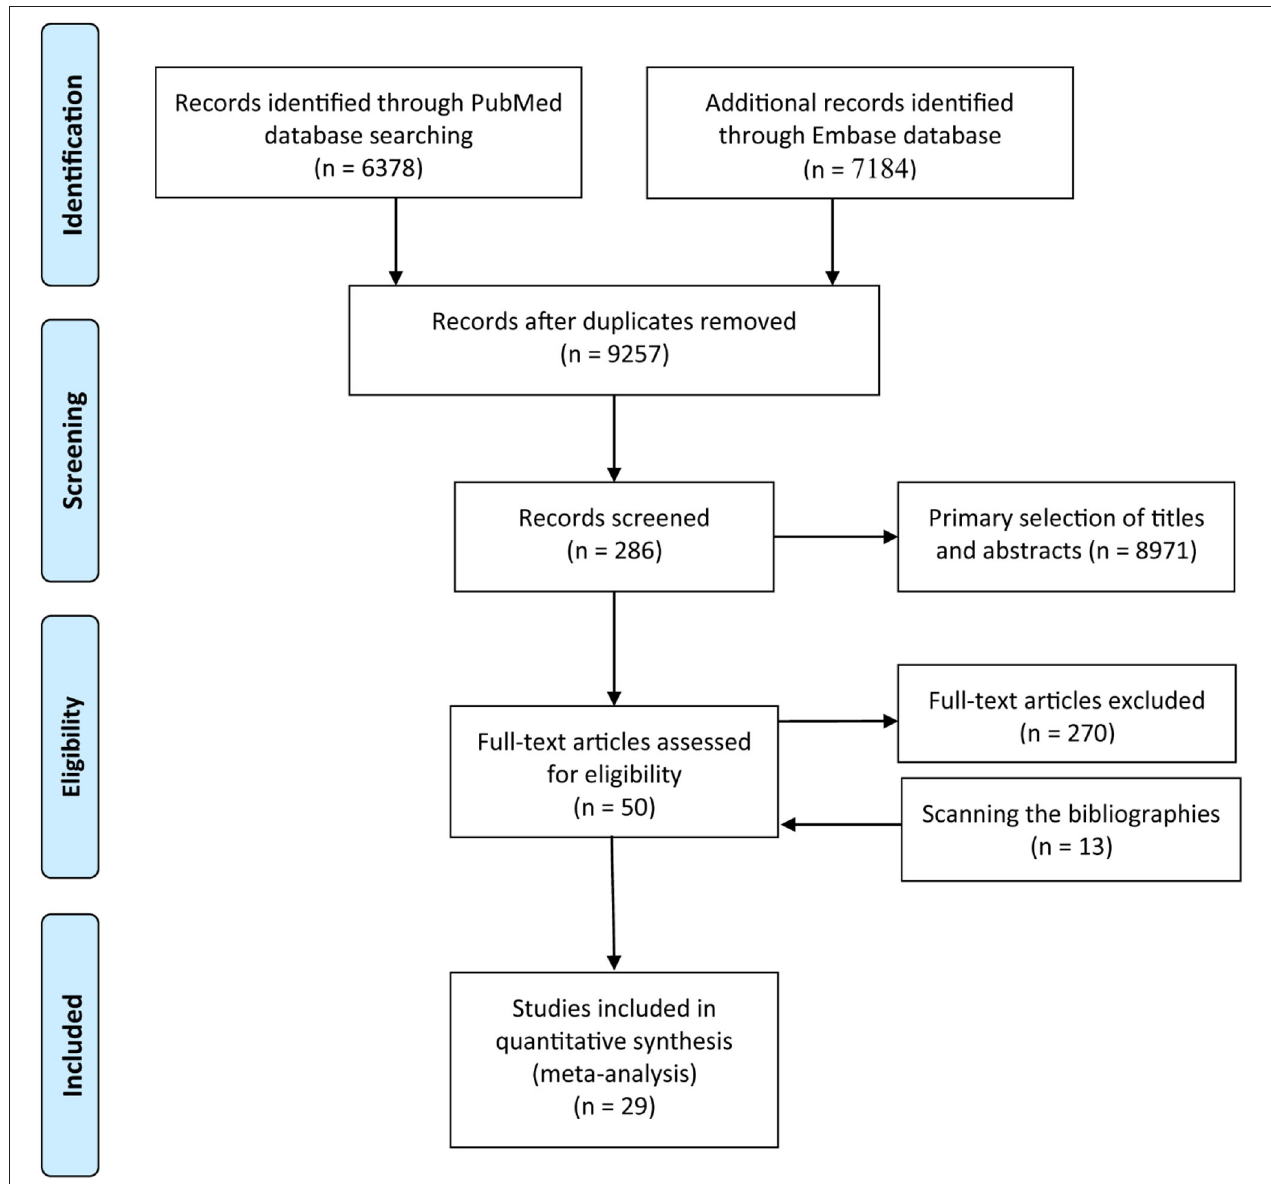
FIGURE 1 | Flow diagram summarizing the pooled analysis phases (i.e., identification, screening, eligibility assessment, and ultimate inclusion).